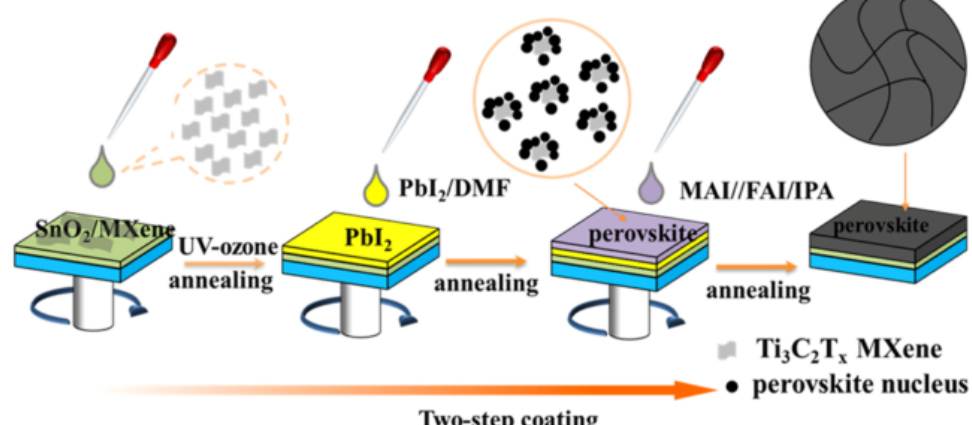
Figure 9. Schematic representation of the manufacturing processes of the perovskite film and the ETL. Reprinted with permission from ref. [123]. Copyright 2021American Chemical Society.